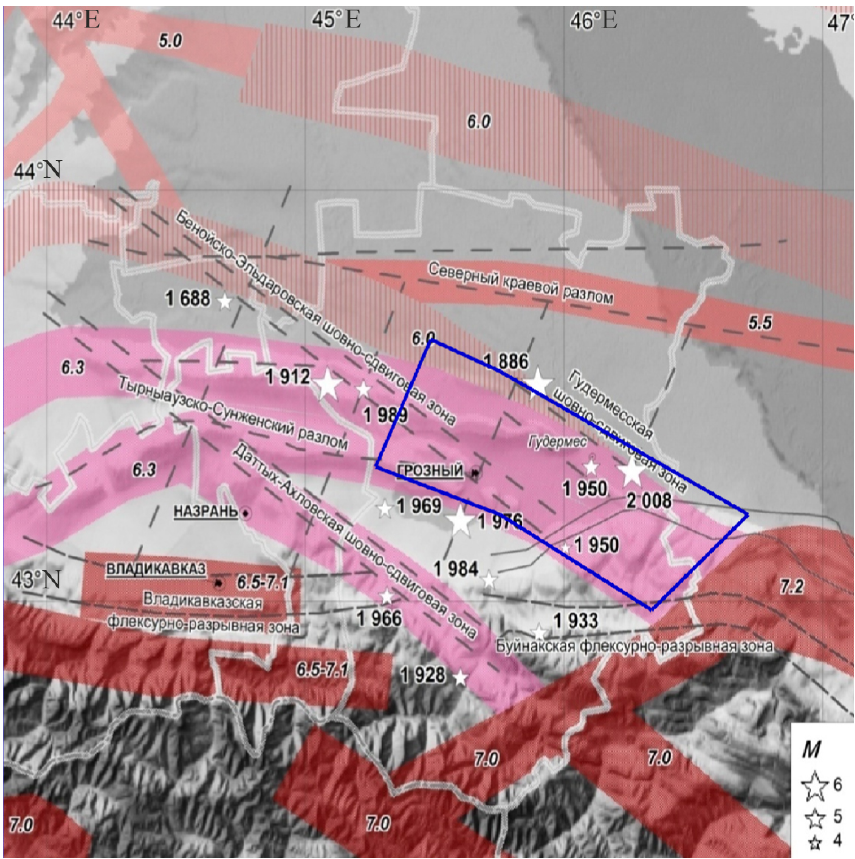
Figure 4. The zone with stable parameters of macroseismic field and map background according to Nesmeyanov et al. (1996) and Rogozhin et al.